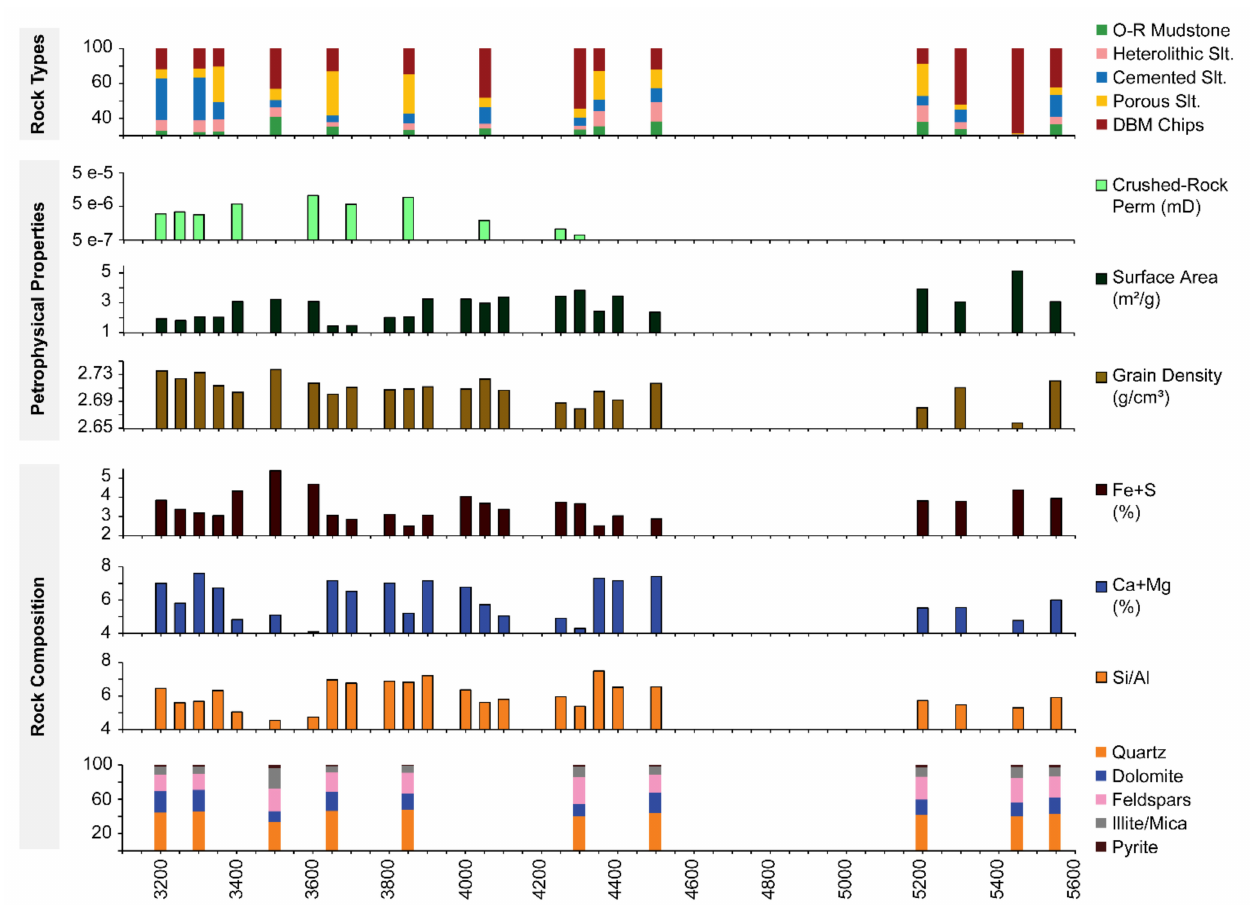
Figure 4. Results from the laboratory analyses conducted on drill cutting samples. Iron plus sulfur (Fe+S) can be used as a proxy for pyrite, the silicon to aluminum ratio (Si/Al) for quartz, and calcium plus magnesium (Ca+Mg) for dolomite. XRD mineralogy and XRF analyses were performed on the exact same sample. The grain density was measured using a helium pycnometer. The surface area was estimated from low-pressure gas (N 2 ) adsorption experiments using the BET method. The crushed-rock permeability was measured using an SMP-200